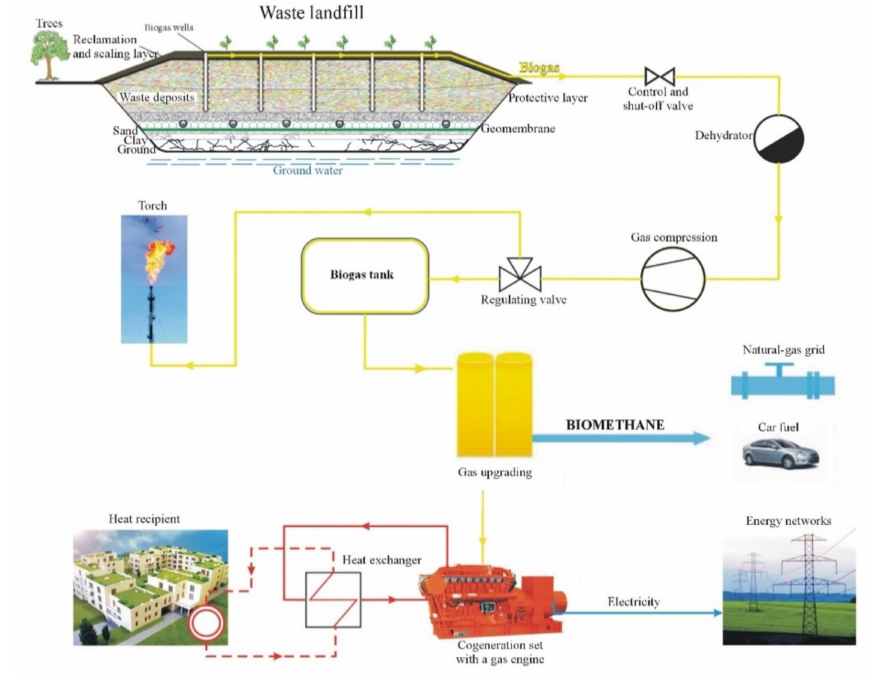
Figure 10. Economic use of BG obtained from municipal